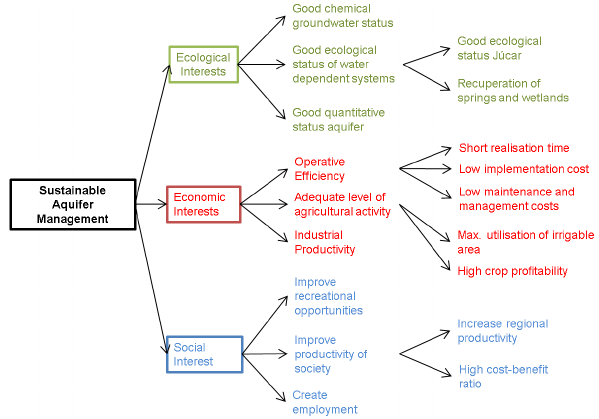
Figure 4. Hierarchy value tree of objectives from interviews with experts and